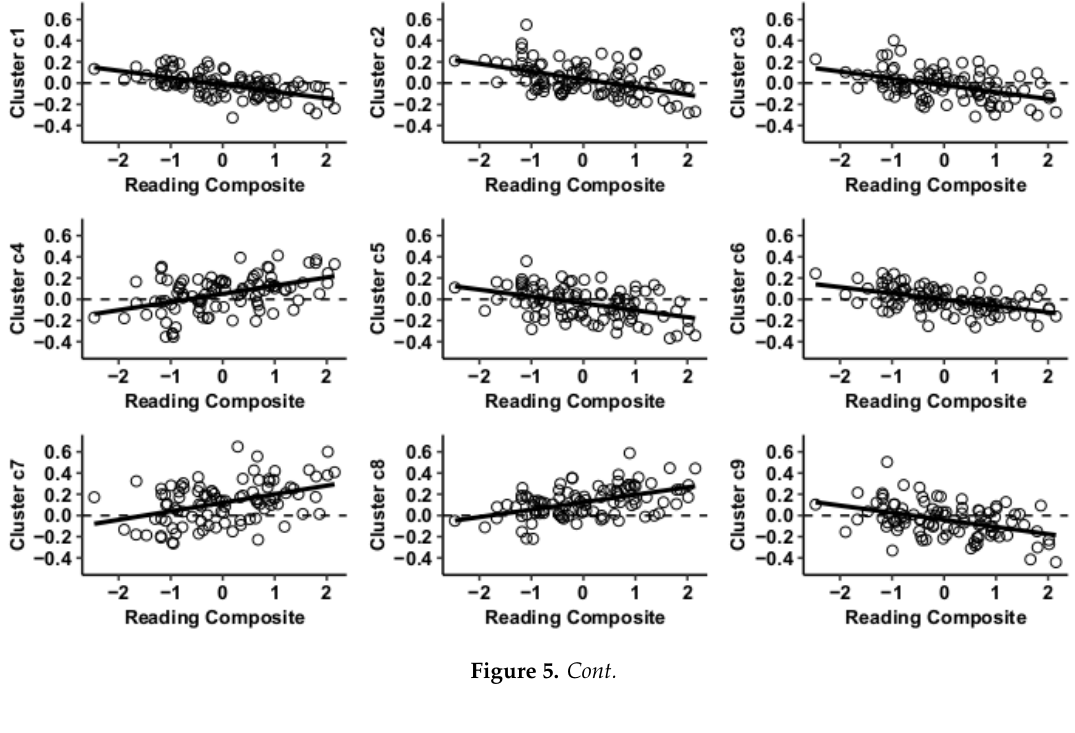
Figure 5. Whole-brain functional connectivity correlations with reading composite score for MVPA Cluster c. Figure 6. Whole-brain functional connectivity correlations with reading composite score for MVPA Cluster d. 4. Discussion This study utilized a data-driven and unbiased, connectome-wide MVPA approach to examine whole-brain RsFc in association with reading and mathematics composite scores in a population of typically developing 7- to 9-year-old children. Our main findings indicate that a number of network connectivity patterns are associated with performance on a composite measure of reading achievement. More specifically, seed regions in the right inferior temporal gyrus (cluster a) and left frontal pole (cluster d) showed increased anticorrelations between seed regions located in the limbic